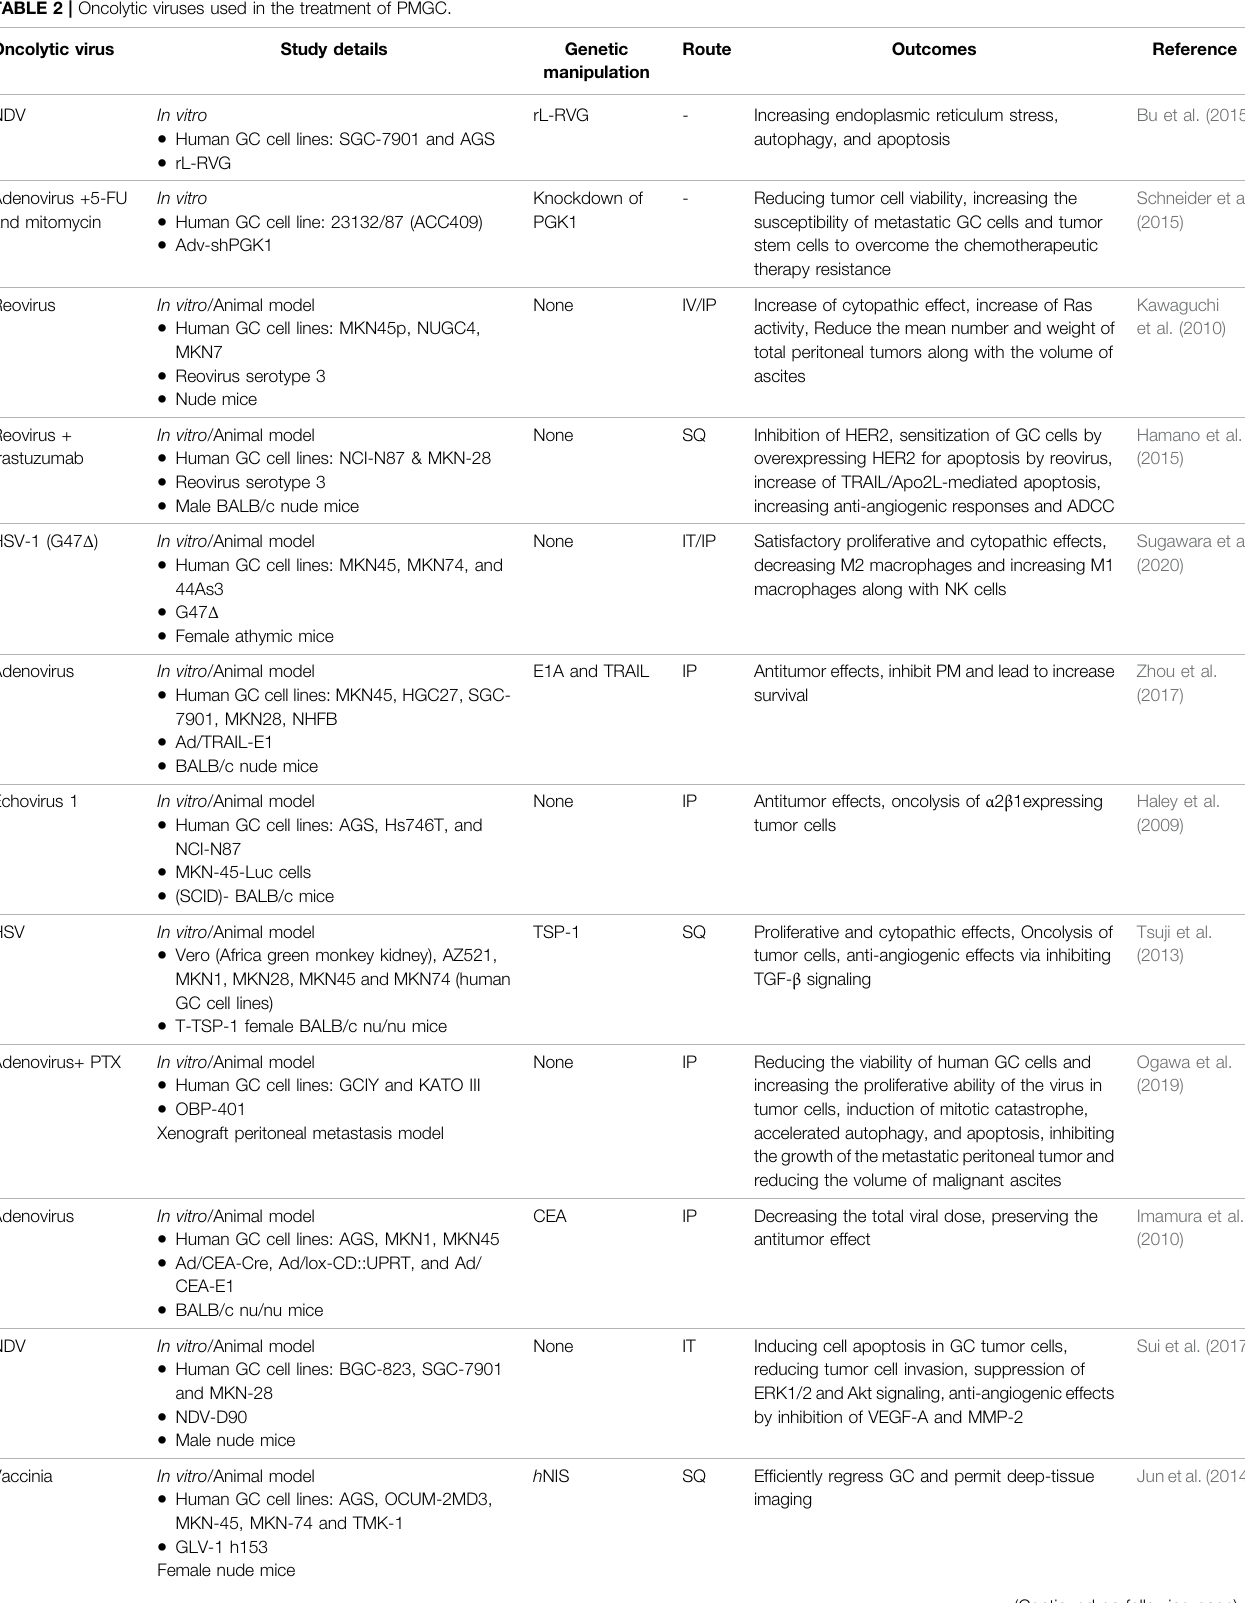
TABLE 2 | Oncolytic viruses used in the treatment of PMGC. Oncolytic